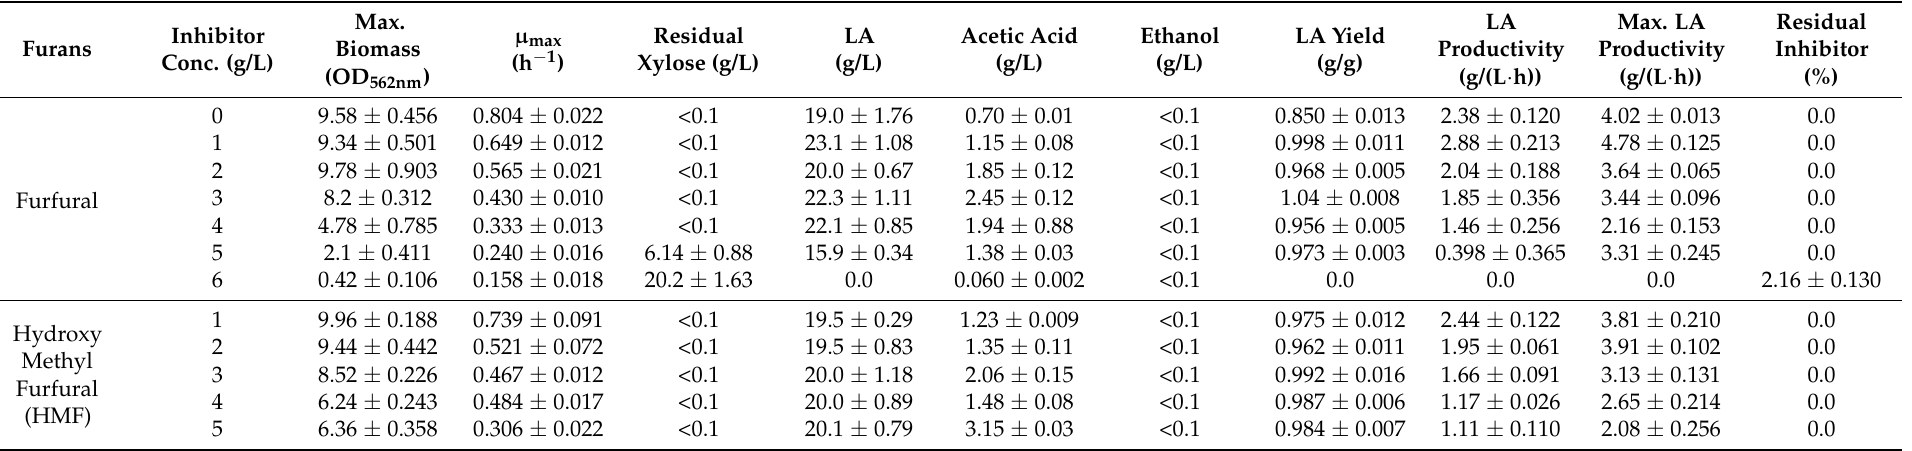
Table 2. Effect of furans on lactic acid fermentation efficiency by Bacillus coagulans Azu-10.